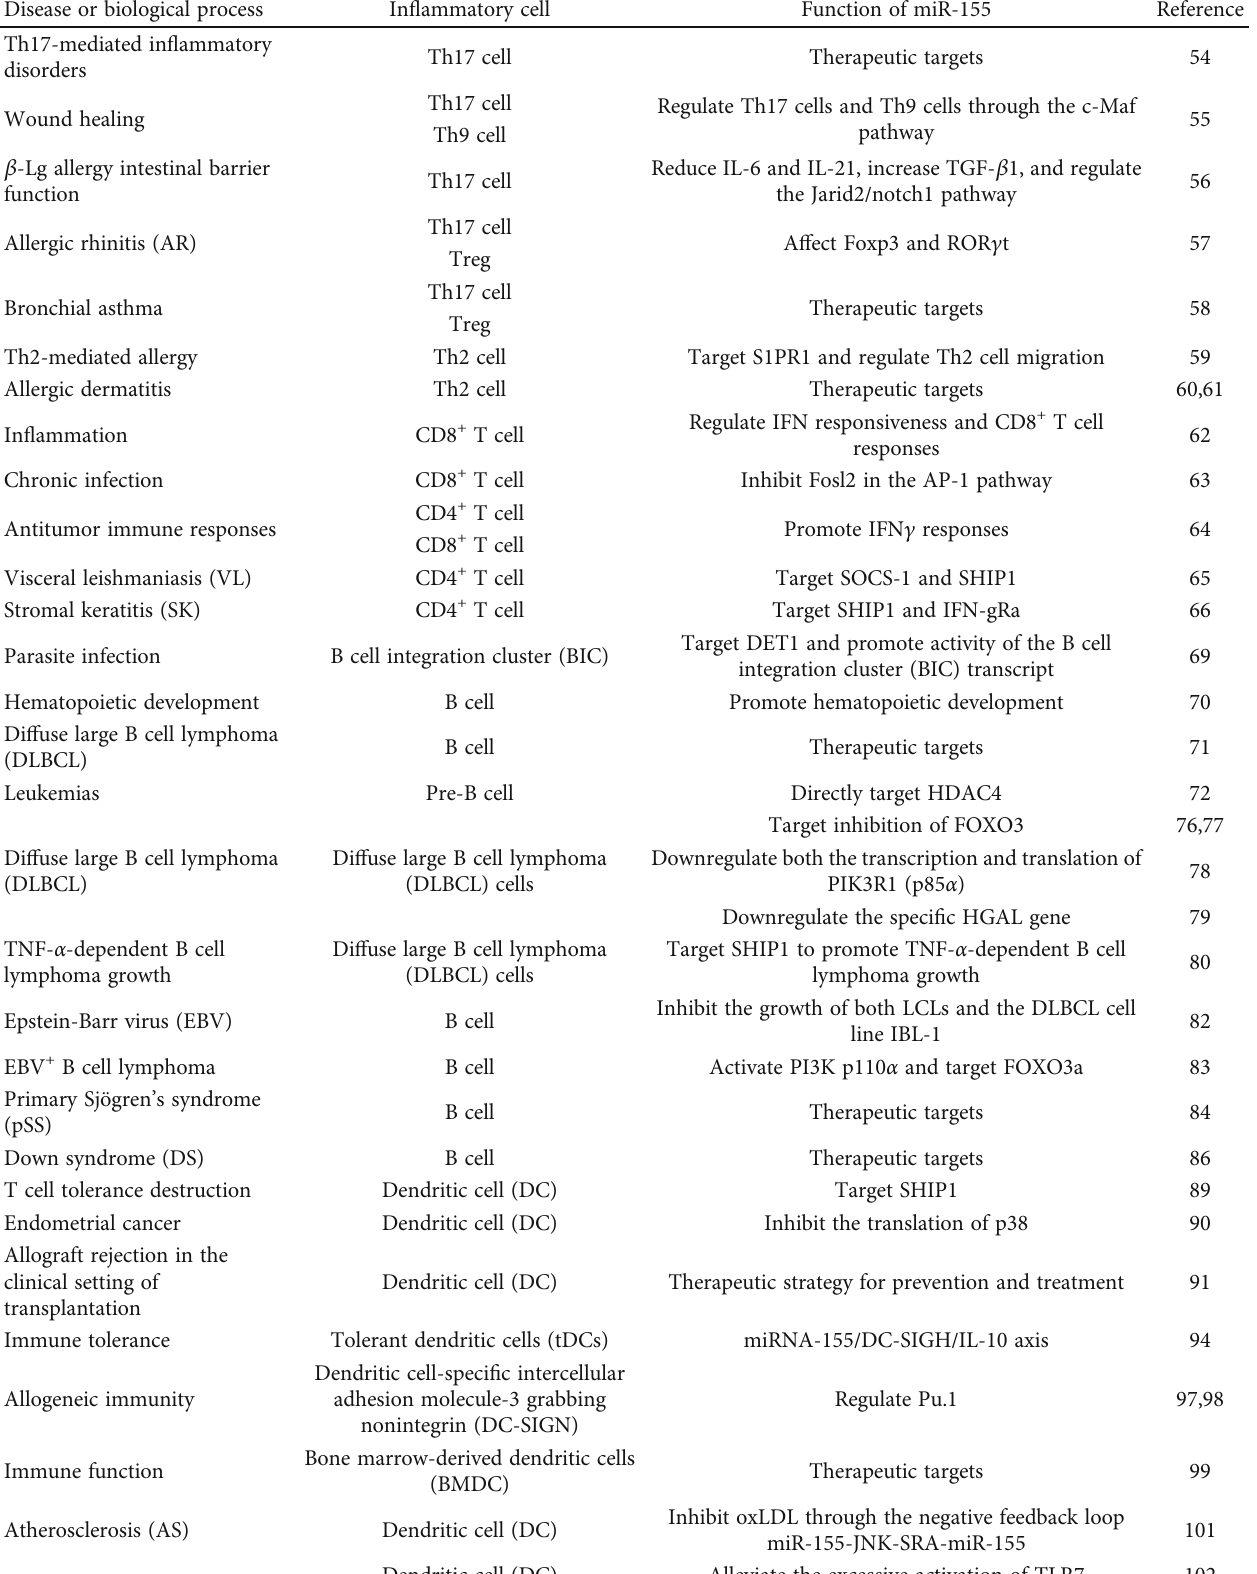
Table 1: Biological function of miR-155 in di ff erent in fl ammatory